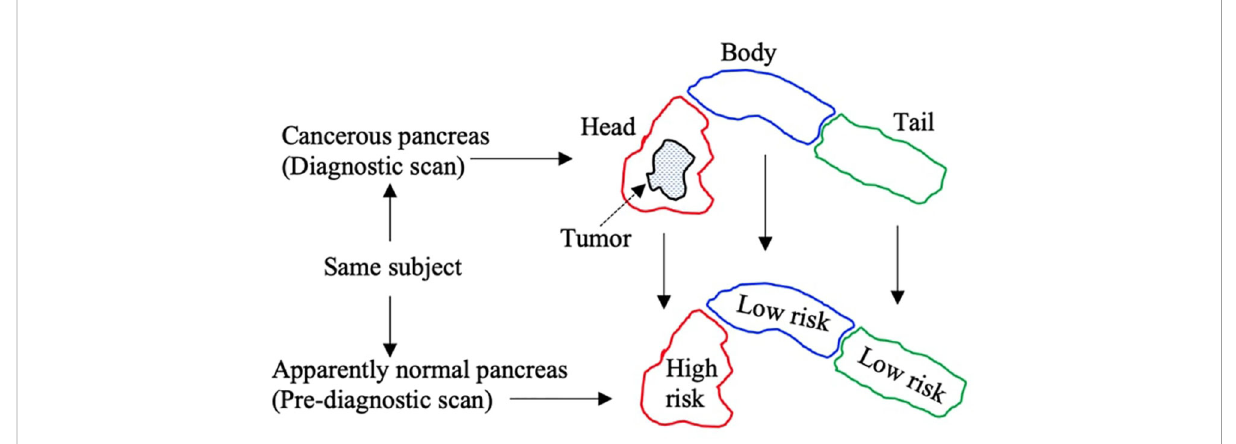
FIGURE 2 Pictorial description of specifying grades to subregions in pre-diagnostic scans. Tumor is observed in head subregion of diagnostic scans, and so the corresponding head subregion in pre-diagnostic scan is marked ‘ high risk ’ , whereas the rest of subregions are marked ‘ low risk ’ .